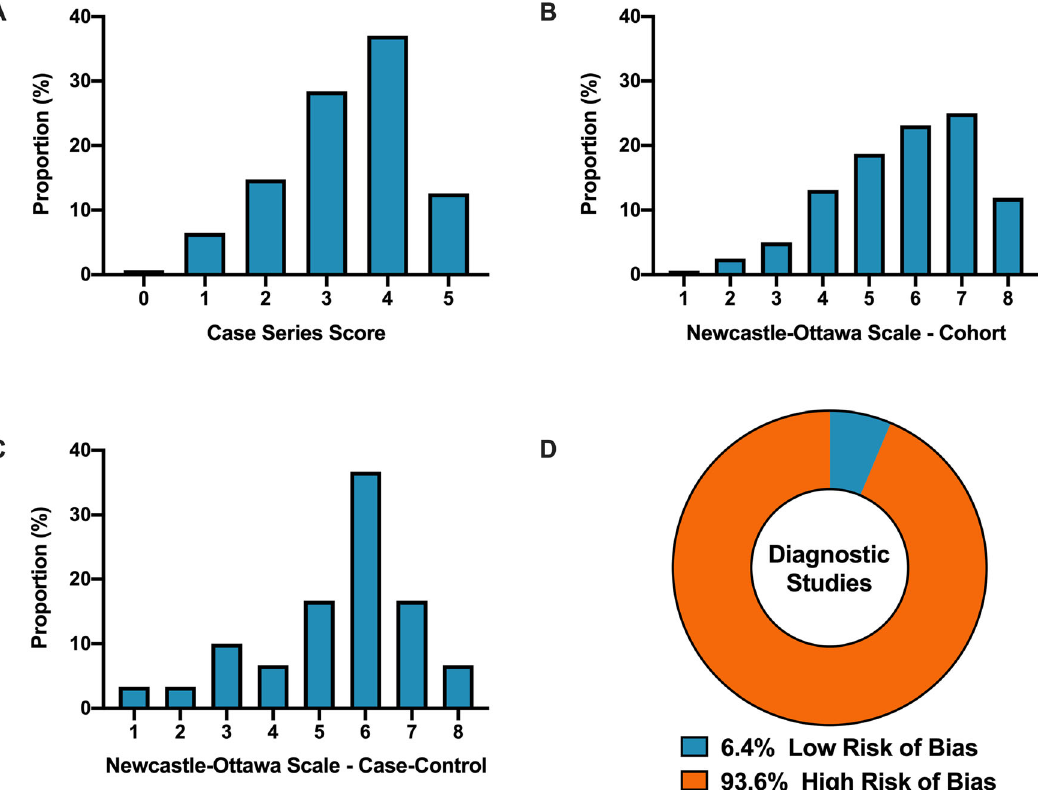
Fig. 2 COVID-19 clinical literature quality assessment. A Distribution of COVID-19 case series studies scored using the Murad tool ( n = 380). B Distribution of COVID-19 cohort studies scored using the Newcastle – Ottawa Scale ( n = 199). C Distribution of COVID-19 case – control studies scored using the Newcastle – Ottawa Scale ( n = 38). D Distribution of COVID-19 diagnostic studies scored using the QUADAS-2 tool ( n = 63). In panel D , blue represents low risk of bias and orange represents high risk of